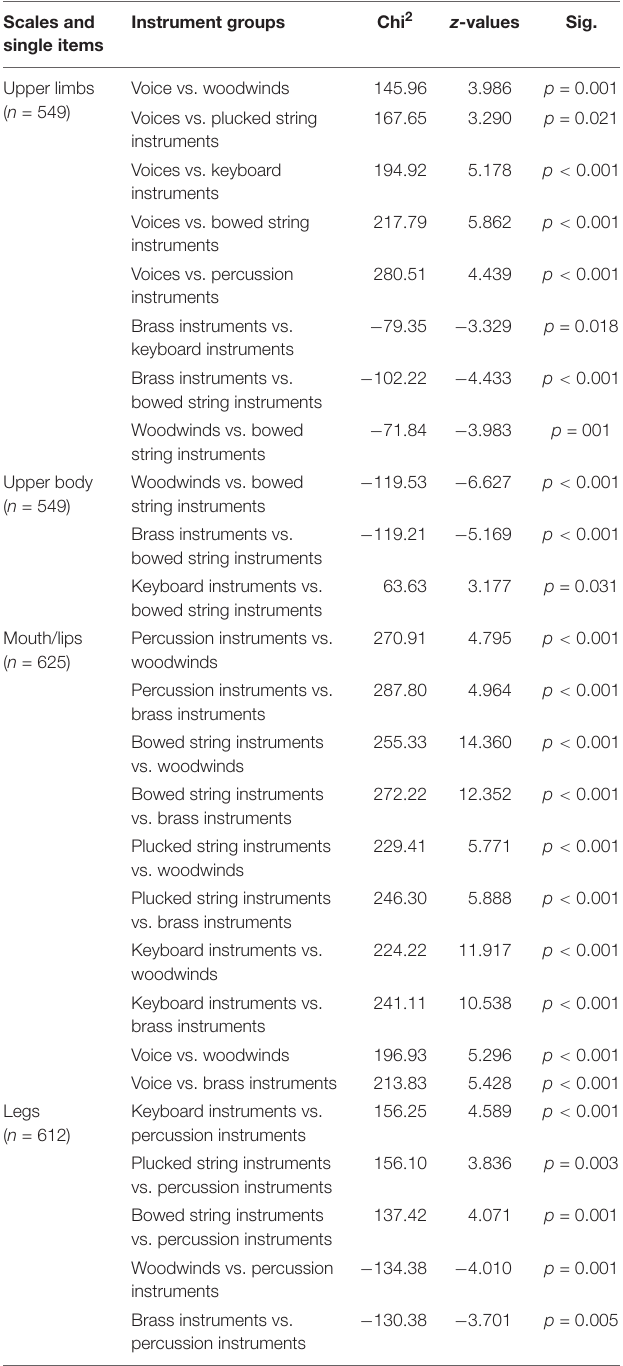
TABLE 8 | Kruskal–Wallis H test on differences in frequency of PRP between instrument groups. Scales and Instrument groups Chi 2 z -values Sig. single items